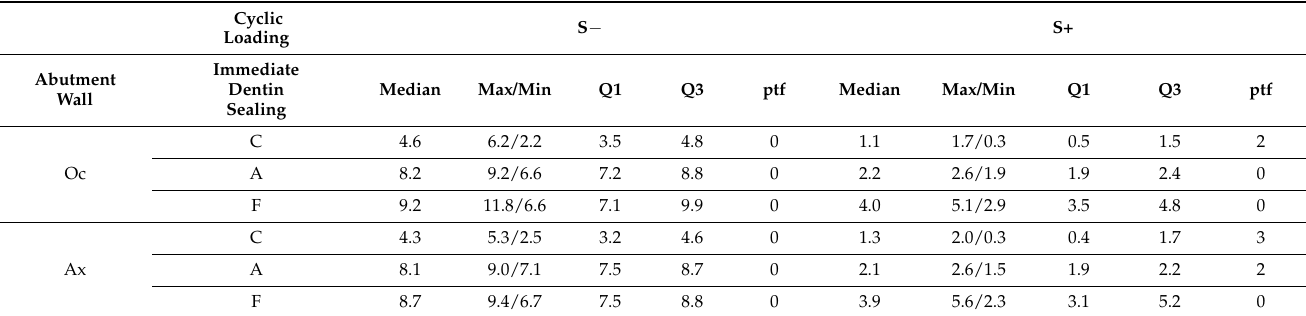
Table 2. Micro-tensile bond strength test results.